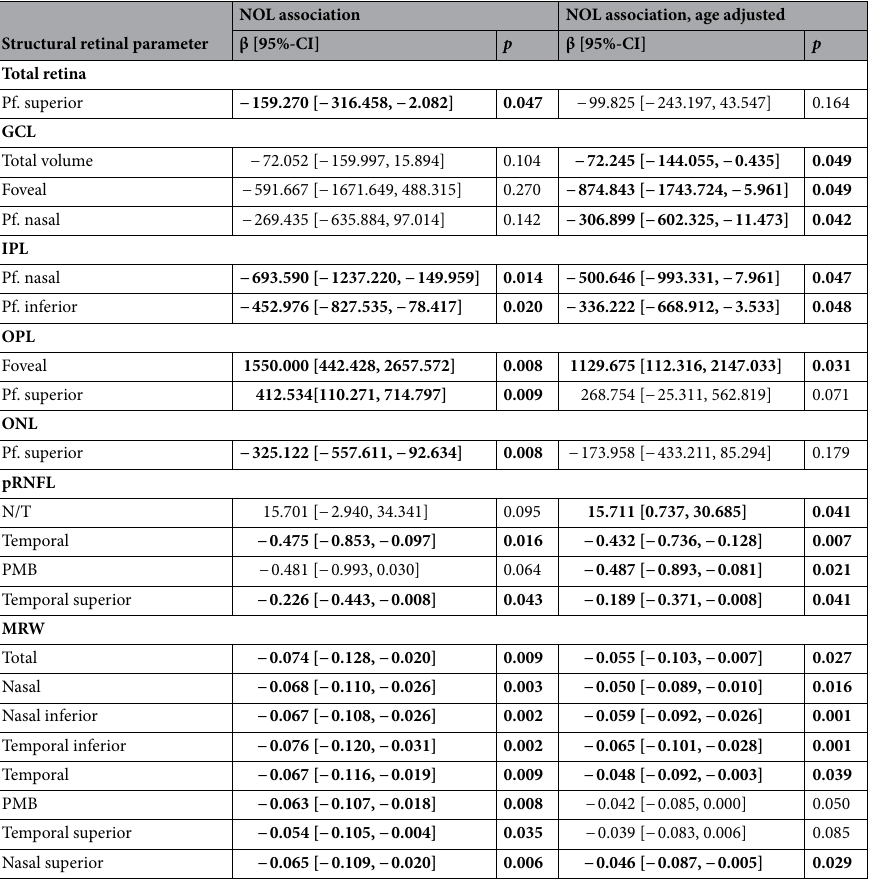
Table 4. Results of linear regression of structural retinal parameters and number of white matter lesions in patients with cerebral small vessel disease. Associations between retinal parameters and NOL were assessed using linear regression. Model 1: univariate regression, Model 2: multivariable regression adjusted for age; significant associations ( p < 0.05) are displayed in bold. In this table, only parameters are listed with a p value < 0.05 in at least one linear regression model. Further results are listed in the supplement. The volumes of the macular layers correspond to the foveal and parafoveal volumes (3-mm-circle). NOL, number of white matter lesions; β, standardized coefficient; CI, confidence interval; pf., parafoveal; GCL, ganglion cell layer; IPL, inner plexiform layer; OPL, outer plexiform layer; ONL, outer nuclear layer; pRNFL, peripapillary retinal nerve fiber layer; N/T, ratio nasal to temporal; PMB, papillo-macular bundle; MRW, Bruch’s membrane opening-minimum rim